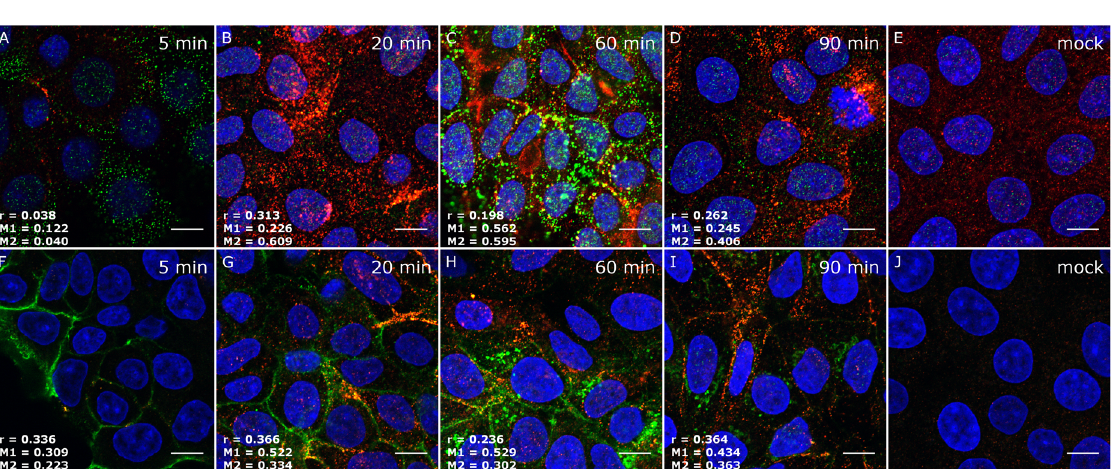
Figure 3. Co-localization of HCoV-OC43 with caveolin-1. Entry of HCoV-OC43 or cholera toxin B (CTB) was studied with confocal microscopy. Respective time points are indicated in the upper right corners. ( A ) HCoV-OC43-infected cells fixed 5 min p.i.; ( B ) 20 min p.i.; ( C ) 60 min p.i.; ( D ) 90 min p.i.; ( E ) mock-infected control cells; ( F ) CTB-overlaid cells fixed 5 min post-inoculation; ( G ) 20 min post-inoculation; ( H ) 60 min post-inoculation; ( I ) 90 min post-inoculation; ( J ) not-overlaid control cells. The virus and CTB are visualized in green, caveolin-1 is shown in red, and nuclei are presented in blue. Scale bar = 10 μ m. Co-localization parameters: r – Pearson’s coefficient; M1 - Manders’ coefficient M1 (caveolin-1 overlapping with the virus); M2 - Manders’ coefficient M2 (the virus overlapping with caveolin-1). The experiment was conducted at least thrice, and representative images are